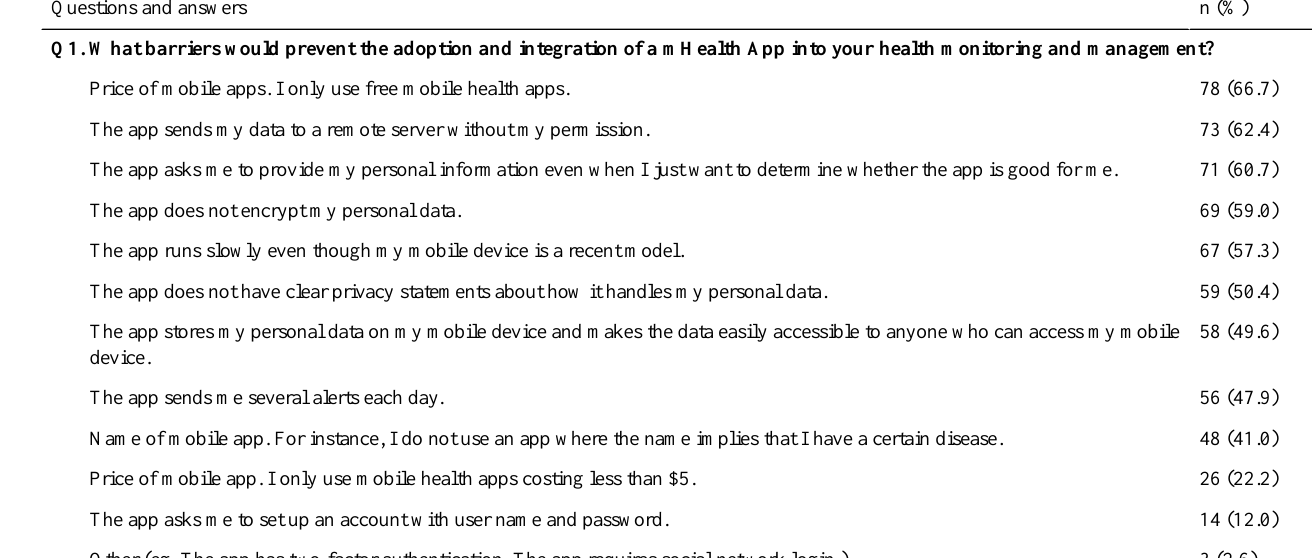
n (%)Questions and